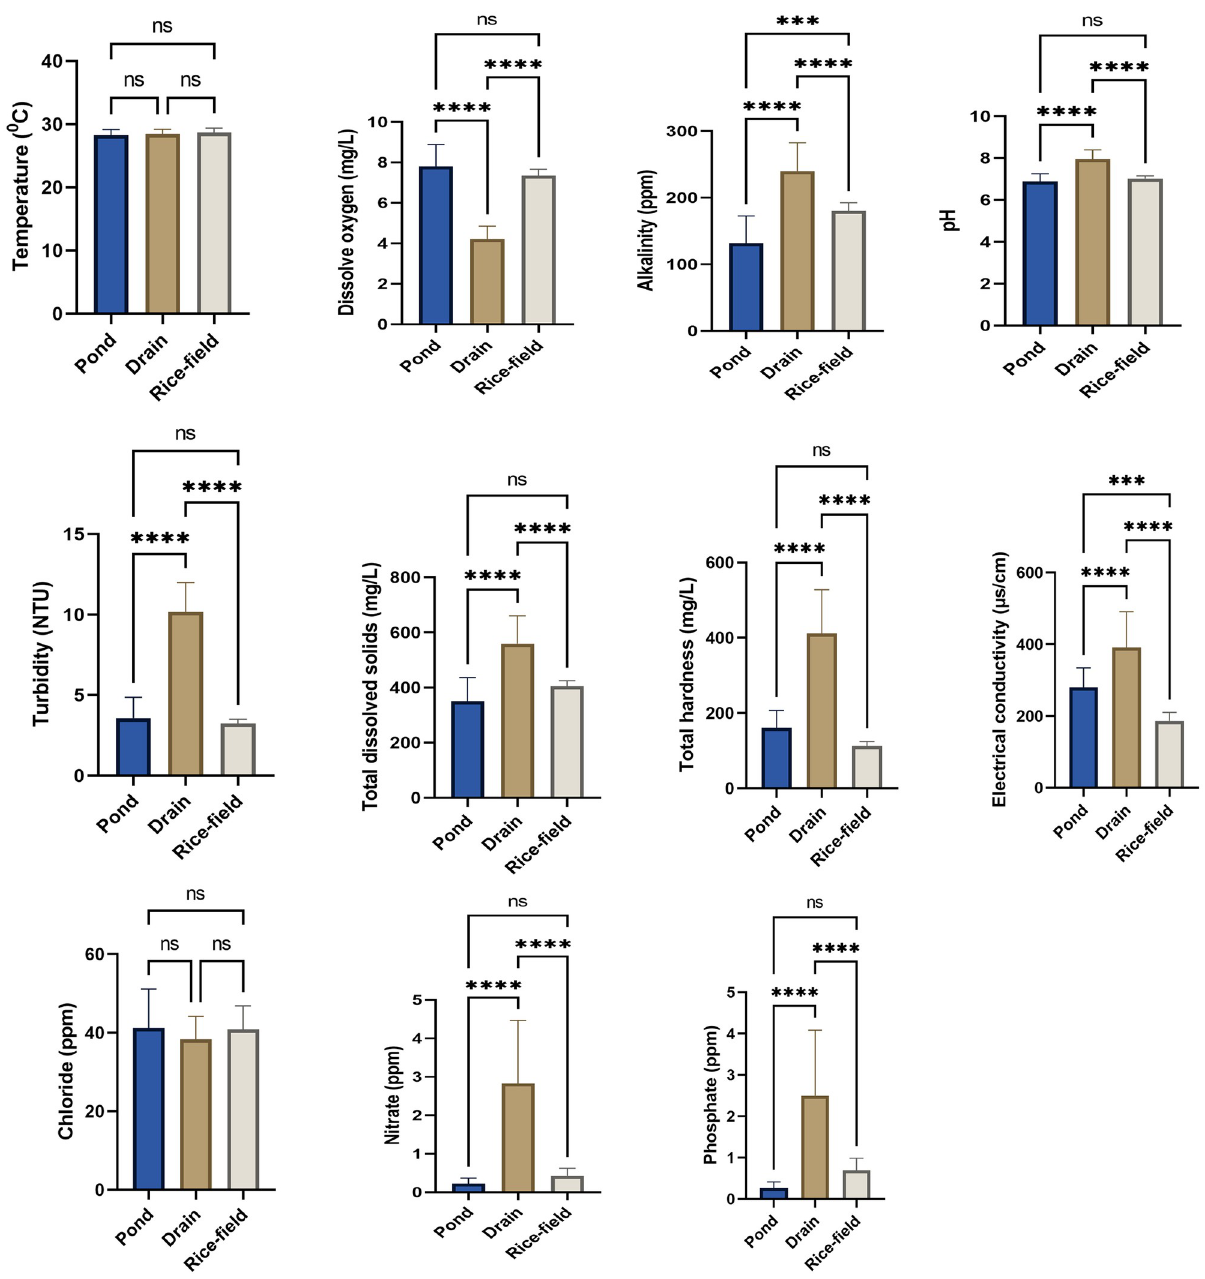
Fig 3. Physico-chemical parameters of different habitat types during monsoon season. An asterisk above given bar indicates significant difference. ‘ ���� ’ indicates p < 0.0001, ‘ ��� ’ indicates p < 0.001, ‘ �� ’ indicates p < 0.01, ‘ns’ indicates p > 0.05. and F2 together contributed 72.55% of the total variance (60.53% and 12.02% variation explained by F1 and F2 respectively) (Fig 6B). Here, the major contributing factors of F1 were turbidity (12.48%) followed by hardness (12.18%), D.O (11.94%), nitrate (10.54%), pH (10.48%) and phosphate (10.35%), whereas factors that contributed in F2 mostly were temper- ature (34.30%) & L.D (31.94%). In this plot, parameters that showed positive association with F1 were turbidity (0.95), hardness (0.94), nitrate (0.87), pH (0.87), phosphate (0.86) &